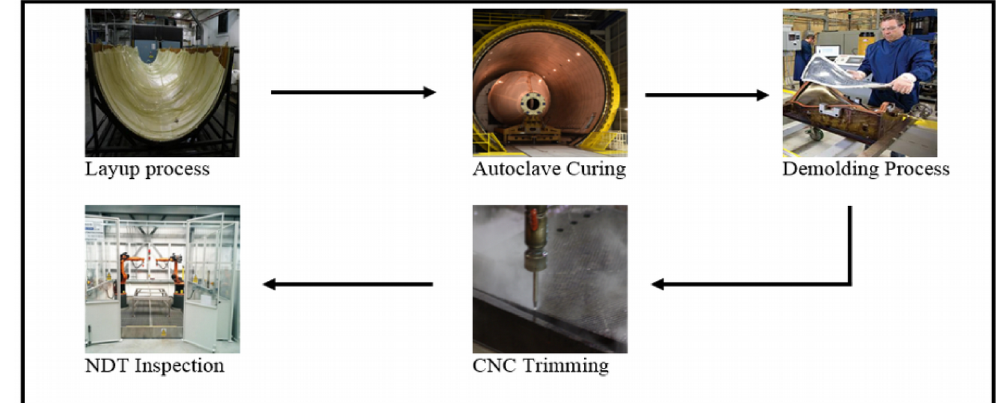
Figure 3. Process flow of aerospace part-manufacturing